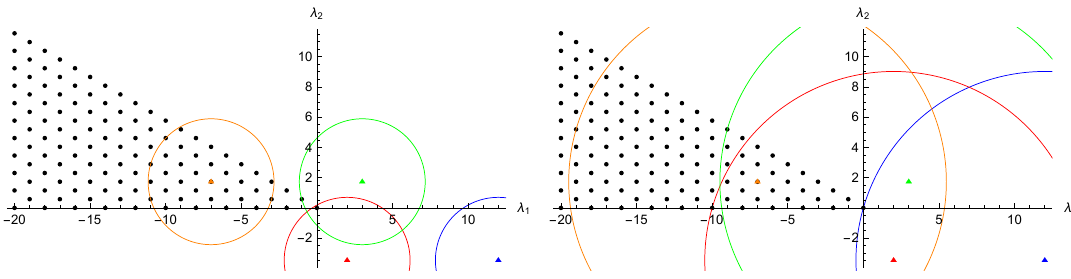
Figure 3 . States (black dots) and \energy shells" for ( g S ; g L ) =(3 ; 2) (blue), =( (cid:0) 2 ; 2) (red), =(3 ; (cid:0) 1) (green) and =( (cid:0) 2 ; (cid:0) 1) (orange) for E = 52